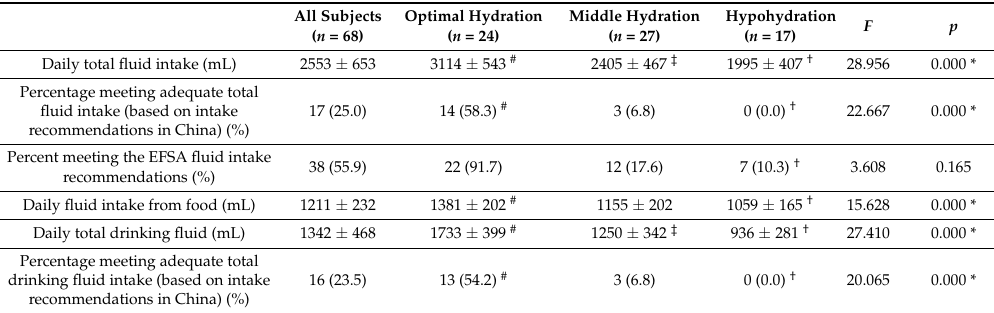
Table 3. Fluid intake of subjects with three hydration